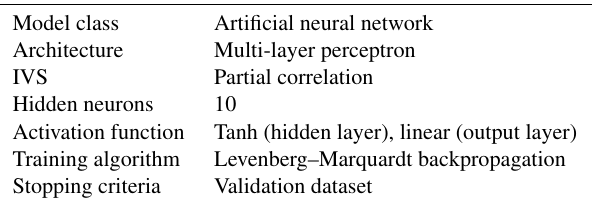
Table 2. Individual learner ANN model description used for both